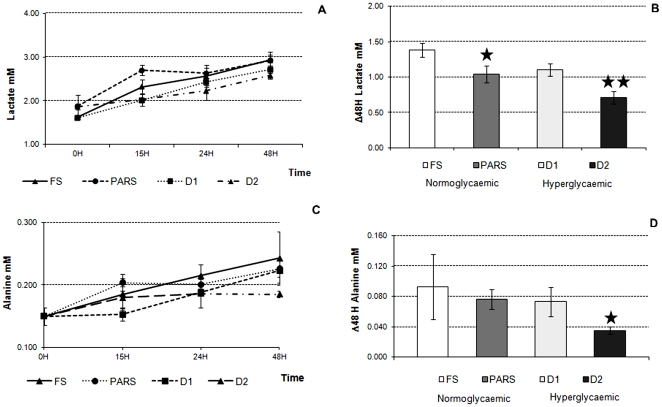
Medium lactate and L-alanine in the 3-way cultures in FS, PARS, D1 and D2 conditions.A) Lactate variations over time. B) Changes in medium lactate concentration with respect to initial media concentration at 48 H (* = p<0.05 vs. FS; ** = p<0.05 vs. D1). C) L-alanine variations over time. D) Changes in medium L-alanine concentration with respect to initial media concentration at 48 H (* = p<0.01 vs. D1). In all cases time 0 represents the levels of metabolites in fresh media. Data are expressed as means ± SD (3≤n≤6). Error bars represent the standard deviation.